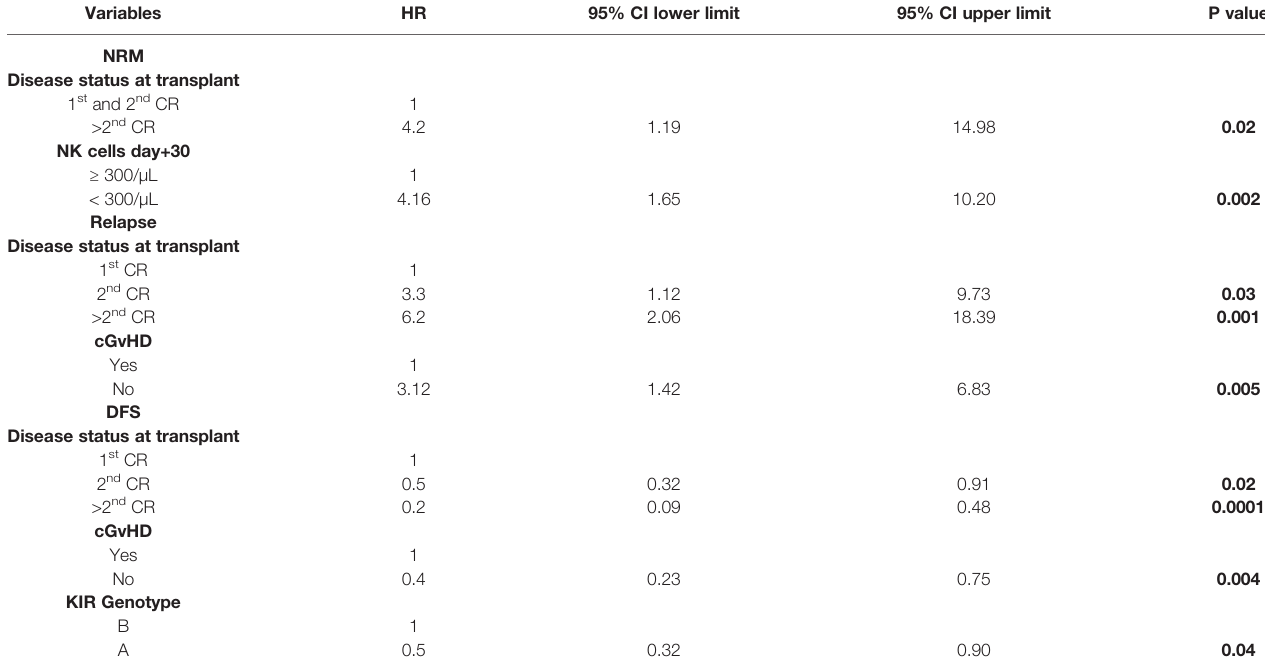
TABLE 3 | MVA of transplant outcomes for whole group (n= 159).